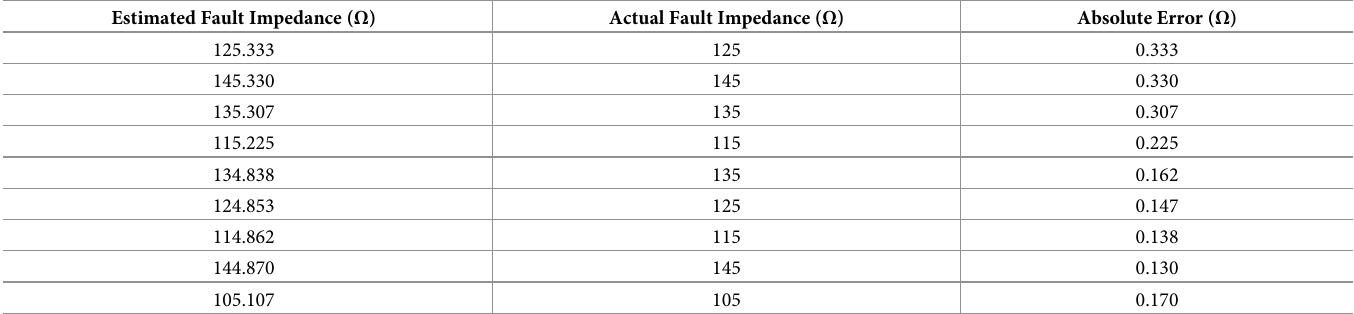
Table 3. Fault impedance estimation using PSO-optimized ANN (18-bus). Estimated Fault Impedance ( Ω